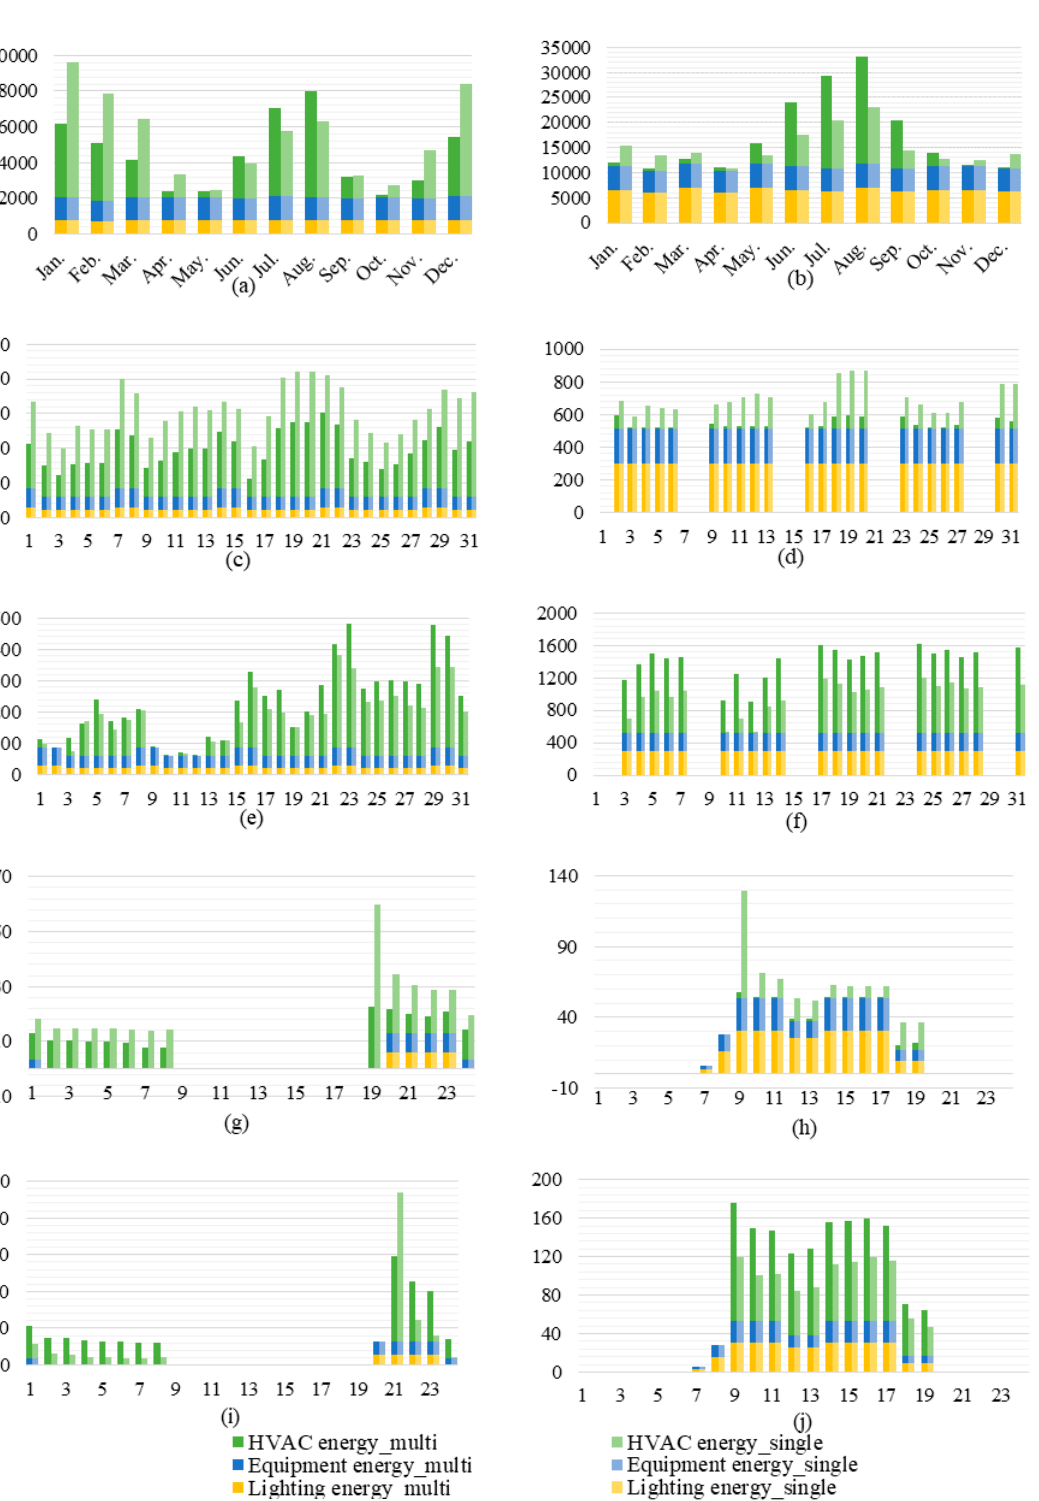
Figure 10. Energy consumption of residential and public buildings (MWh / m 2 · a): ( a ) monthly energy consumption of residential buildings; ( b ) monthly energy consumption of public buildings; ( c ) daily energy consumption of residential buildings in January; ( d ) daily energy consumption of public buildings in January; ( e ) daily energy consumption of residential buildings in July; ( f ) daily energy consumption of public buildings in July; ( g ) hourly energy consumption of residential buildings on 12 January; ( h ) hourly energy consumption of public buildings on 12 January; ( i ) hourly energy consumption of residential buildings on 21 July; ( j ) hourly energy consumption of public buildings on 21 July.